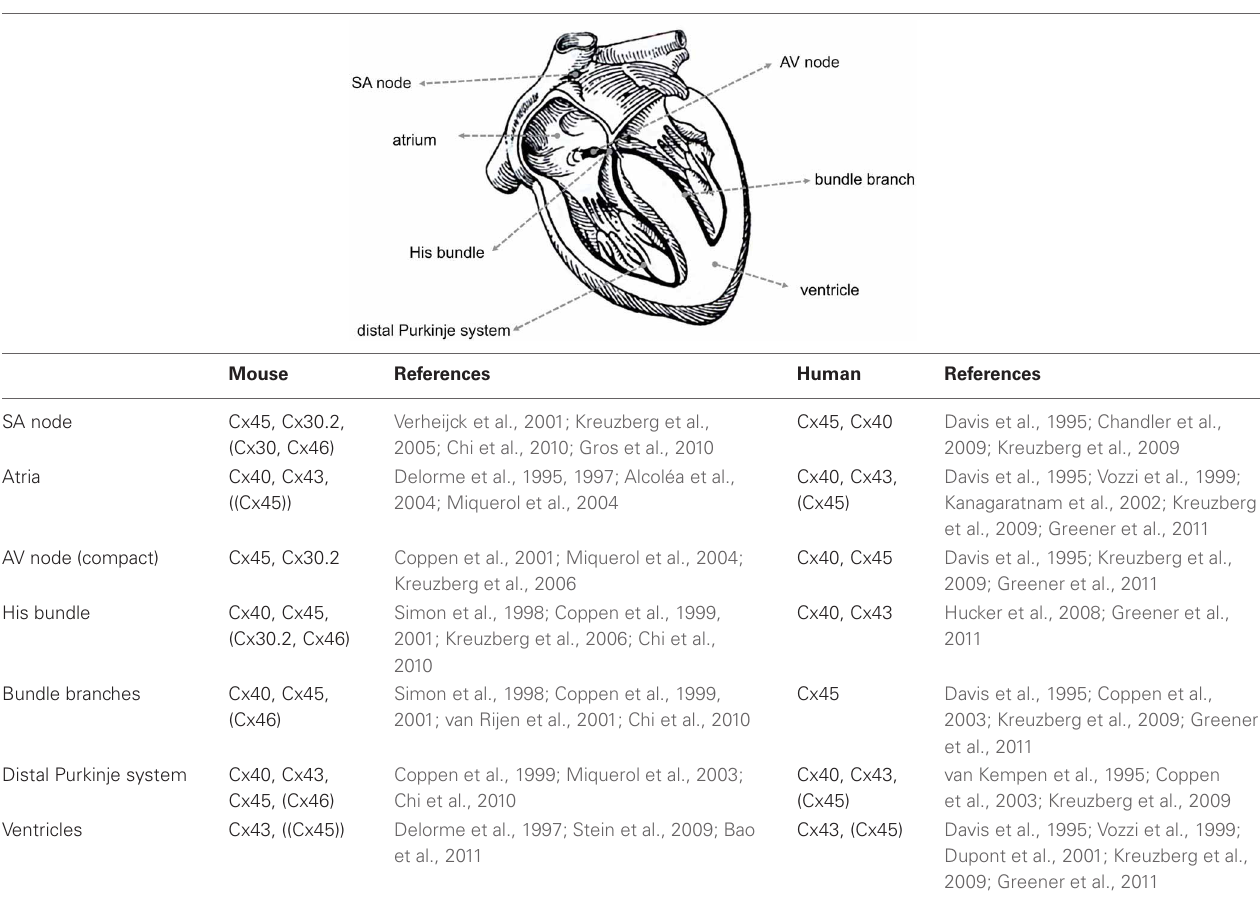
Table 1 | Comparison of Cx regional expression in the mouse and human